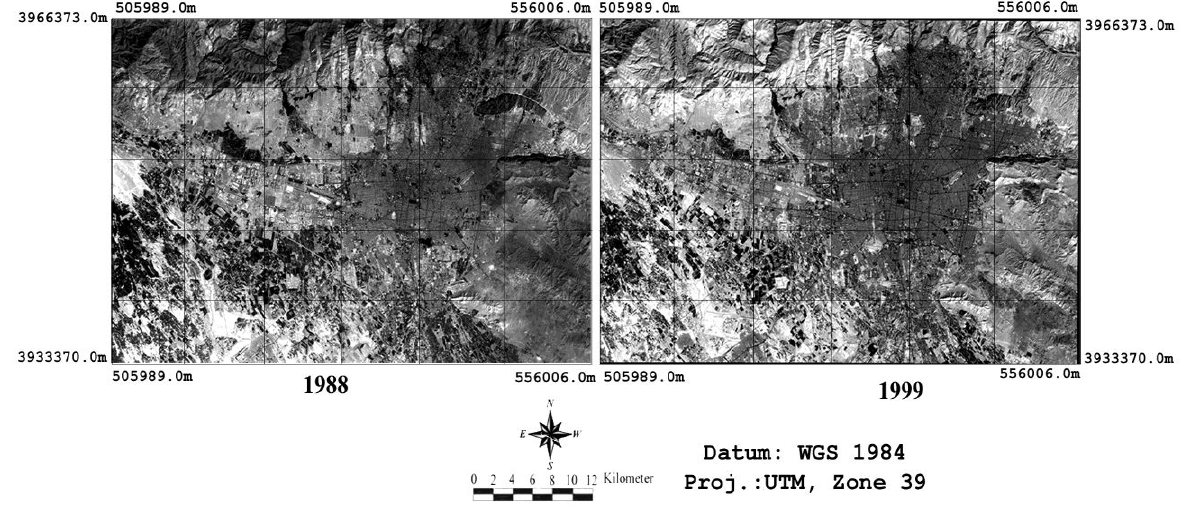
Figure 2. Satellite images of Tehran Metropolitan Area in 1988, 1999,